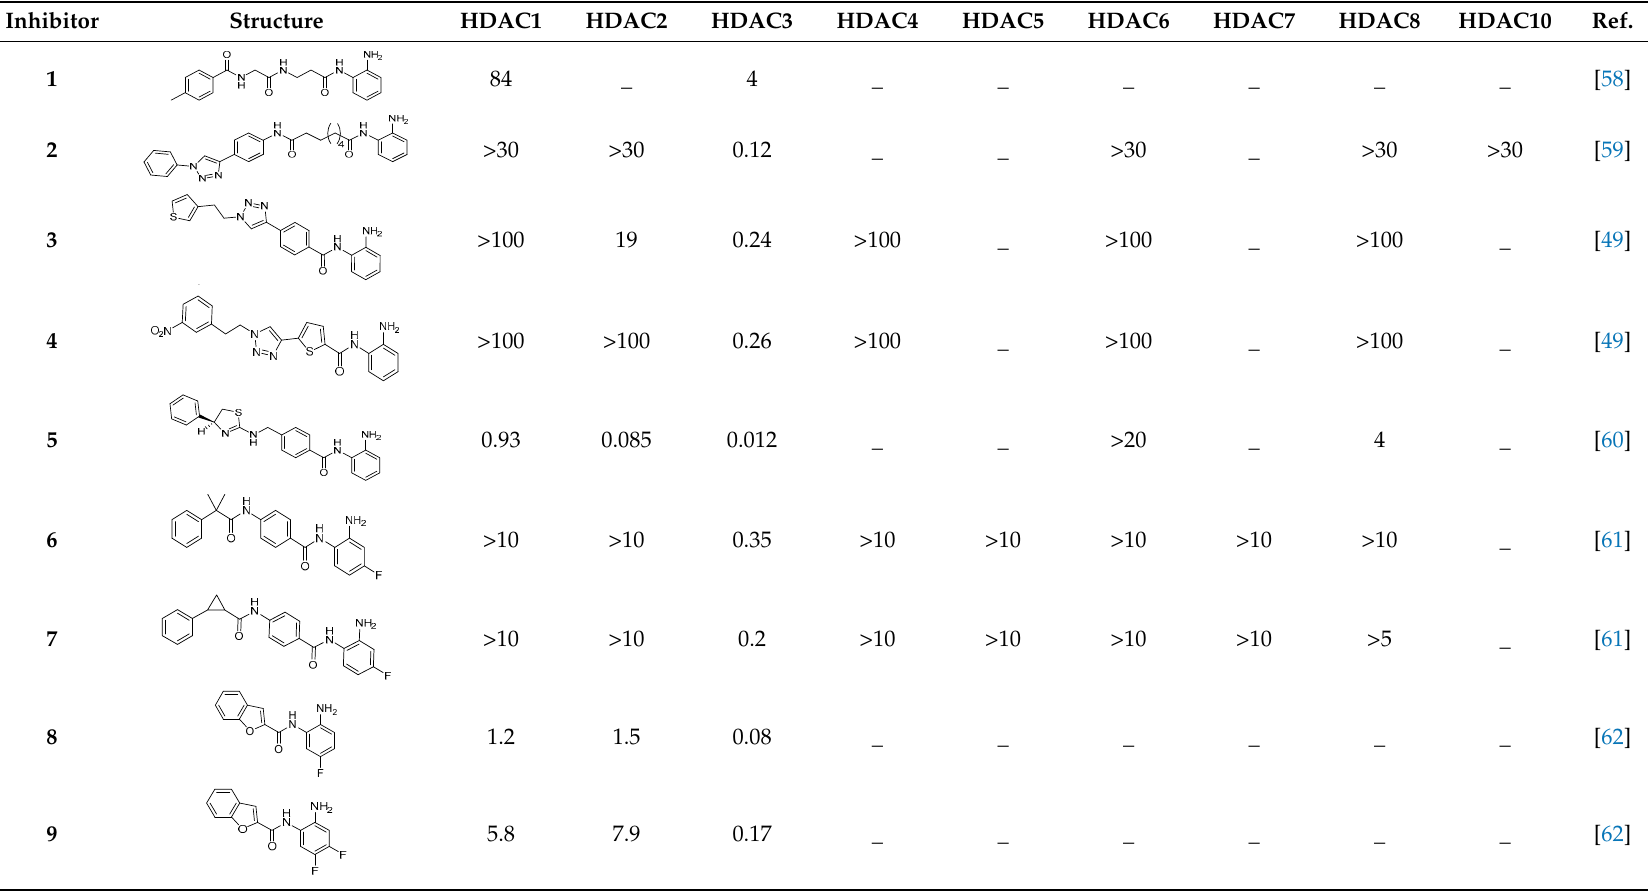
Table 3 The structures of novel selective HDAC3 inhibitors; IC 50 values in μ M.